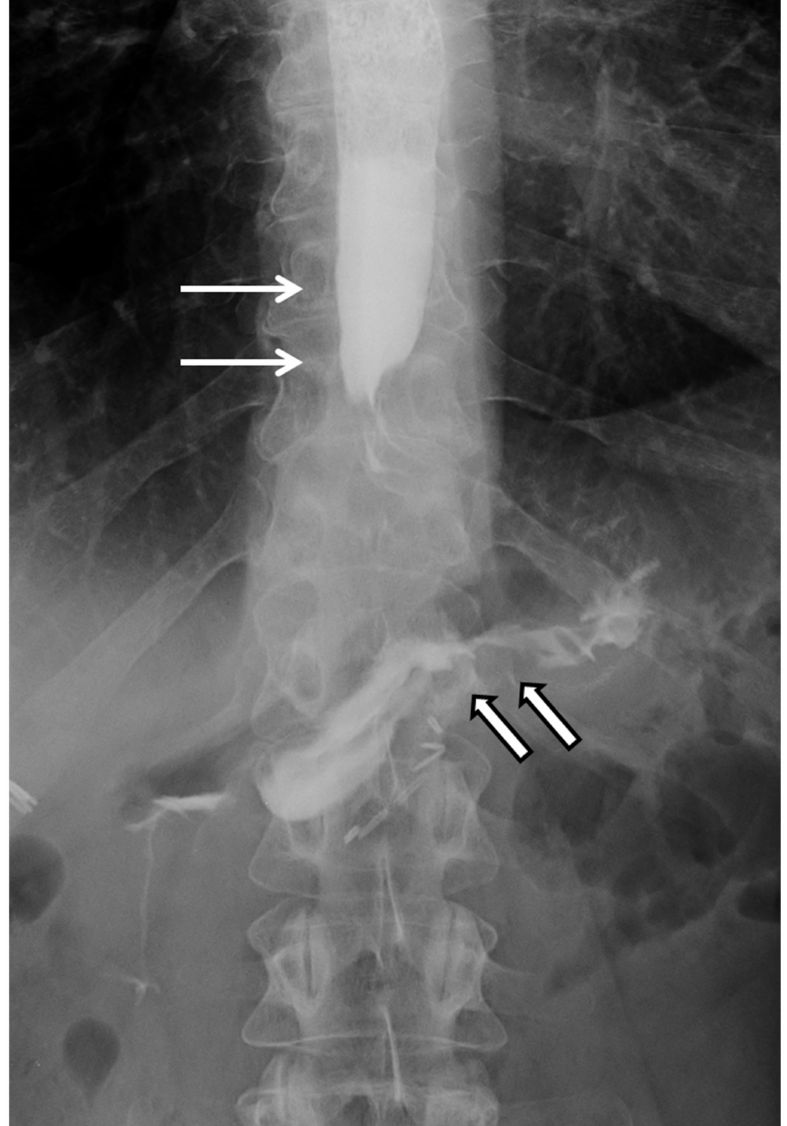
Figure 1. Post-sleeve gastrectomy upper gastrointestinal contrast. Hold-up of the contrast in the distal esophagus and upper part of the sleeve (thin arrows), with delayed gastric emptying sustained by gastric twist above the level of the incisura angularis (thick